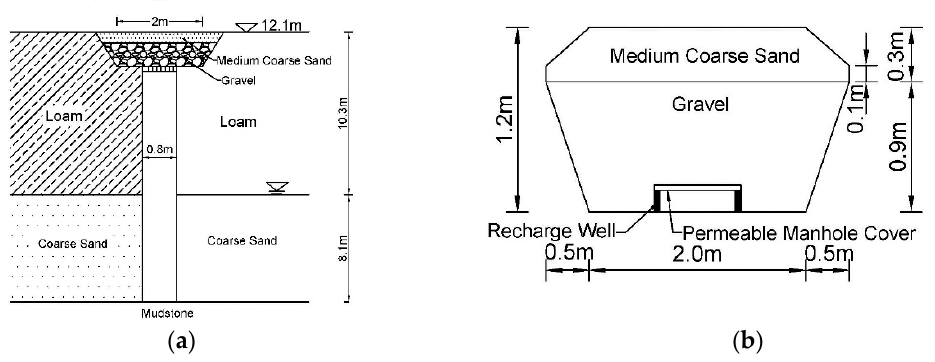
Figure 1. Diagram of the existing anti-filtration recharge well, ( a ) the existing anti-filtration recharge well profile, and ( b ) the recharge pool profile.